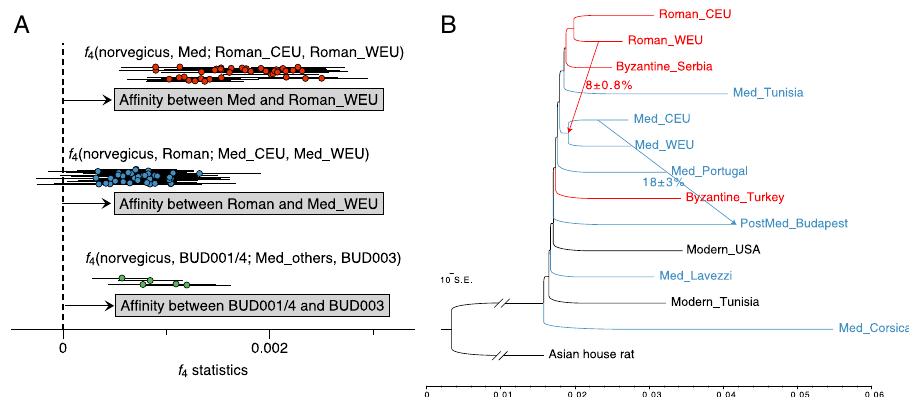
Fig. 4 Gene fl ow among ancient rat populations. A The f -statistics showing admixture between different ancient rat populations. The dots show all the combinations of f 4 -statistics as described above each cluster, with the center being f 4 values and the error bars being ±3SE of the estimates. The SE is determined using jackknife with sample size ( n ) being the number of autosomal scaffolds. The three clusters show the af fi nity between: (top, red) medieval rats (Med) and western European Roman rats (Roman_WEU); (middle, blue) Roman rats (Roman) and western European medieval rats (Med_WEU); and (bottom, green) post-medieval Buda Castle rats (BUD001/4) and the medieval Buda Castle rat (BUD003), respectively. The source data is provided in Supplementary Data 4.2, 4.3 and 4.4. B Admixture graph with two migration events fi tted, estimated by Treemix. The migration edges are displayed by arrow including the introgression fractions and standard errors. The colour of each branch represents the time period of each group: Roman/Byzantine (red) and medieval/post-medieval